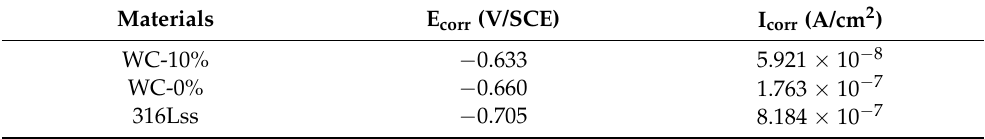
Table 2. The electrochemical parameters of the HEA/WC coatings and 316Lss substrate.